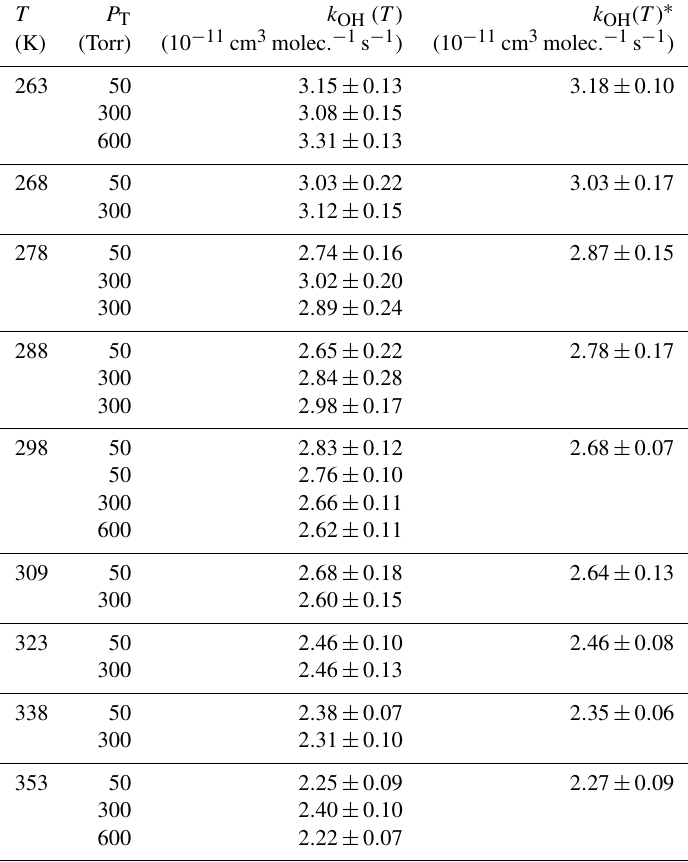
Table 3. Individual rate coefficients of the 2MB + OH reaction as a function of temperature and total pressure.